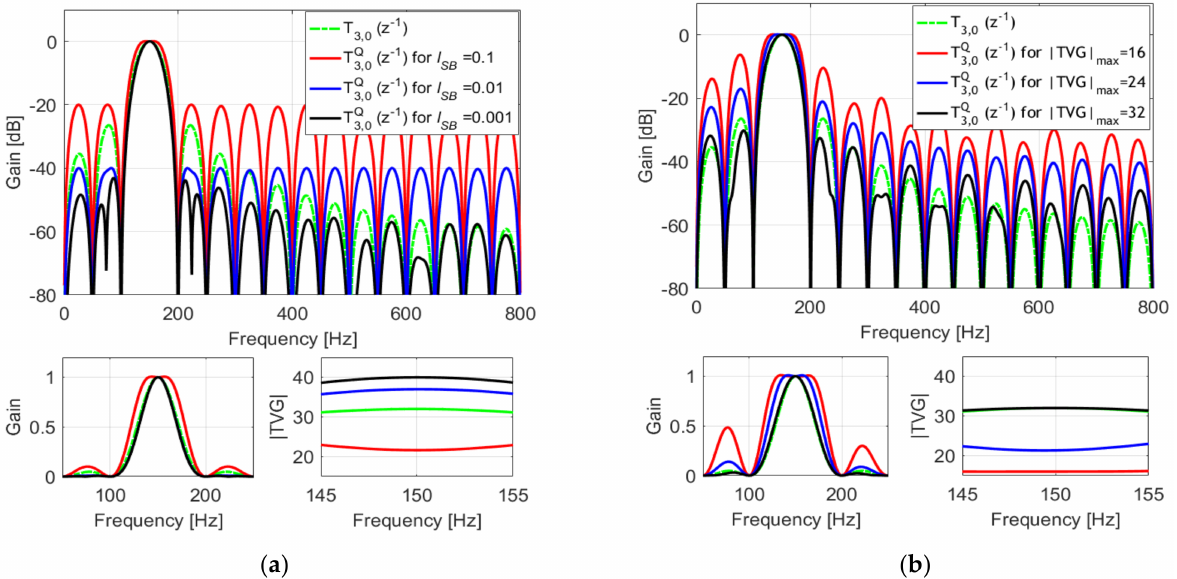
(cid:0) (cid:1) z − 1 ) and reshaped ( T Q ∈ { 16, 24, 32 } max